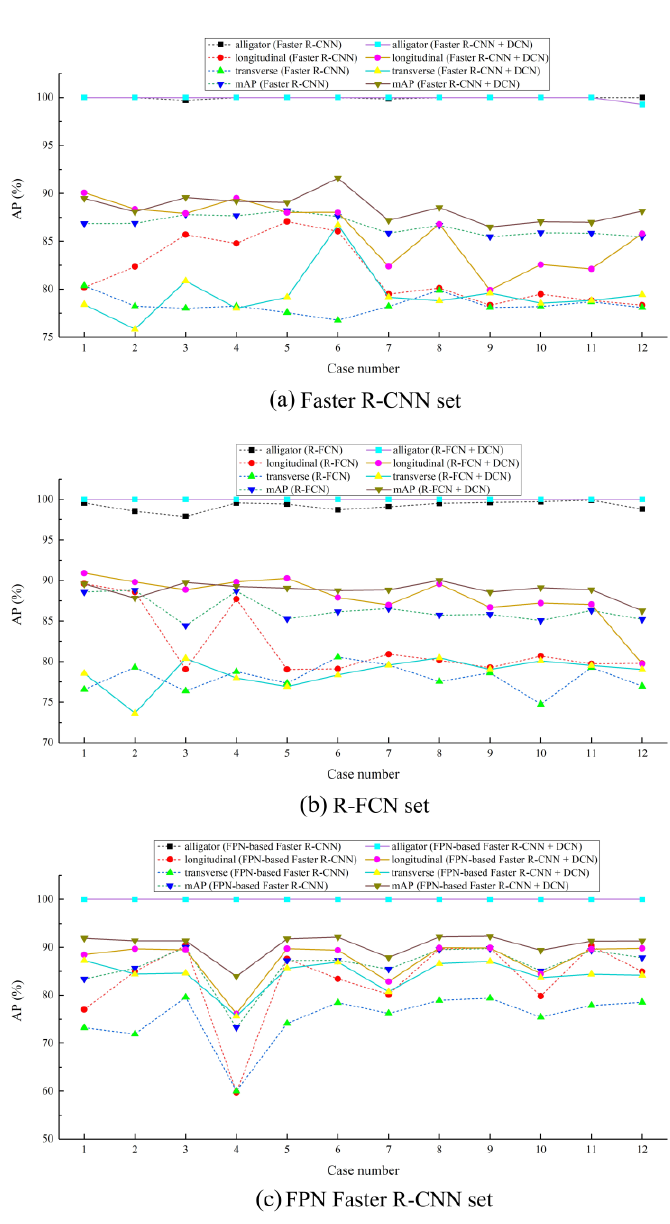
Figure 10. Performance of three sets of models on the testing set.